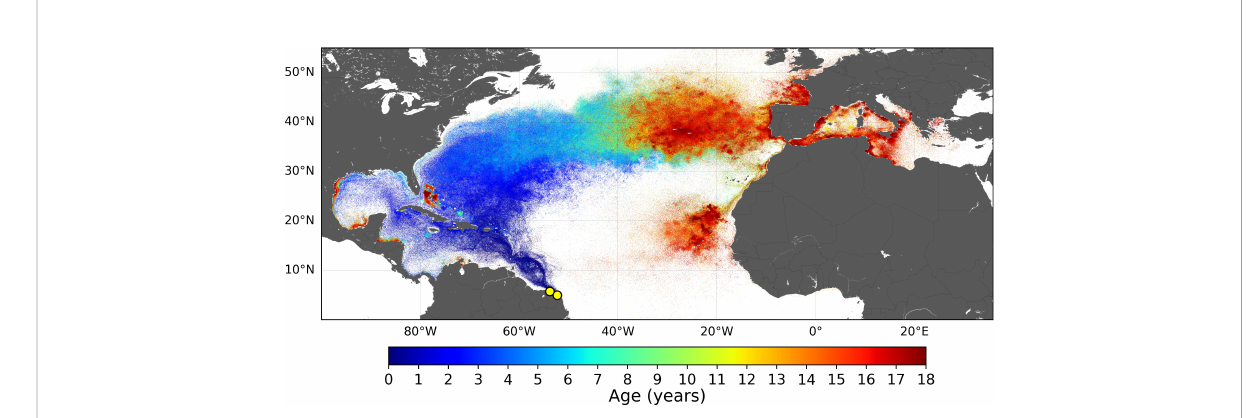
FIGURE 7 Normalized dispersal map for the Guiana stock obtained with T b = 22°C. Only one departure year (2002) was